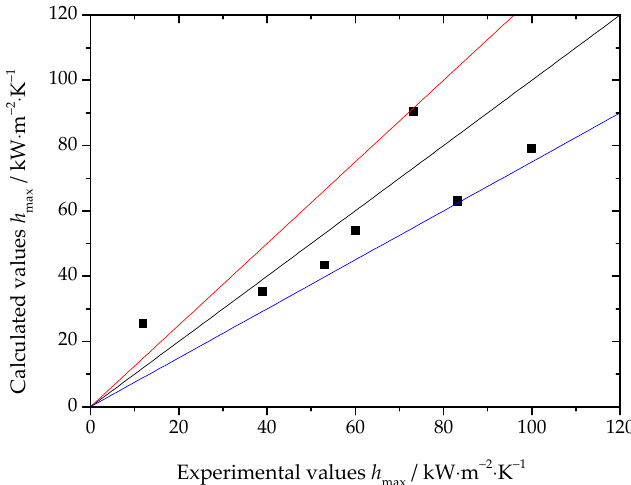
Figure 7. Deviation of the maximum condensation heat transfer coefficients between the calculation results and experiment results.